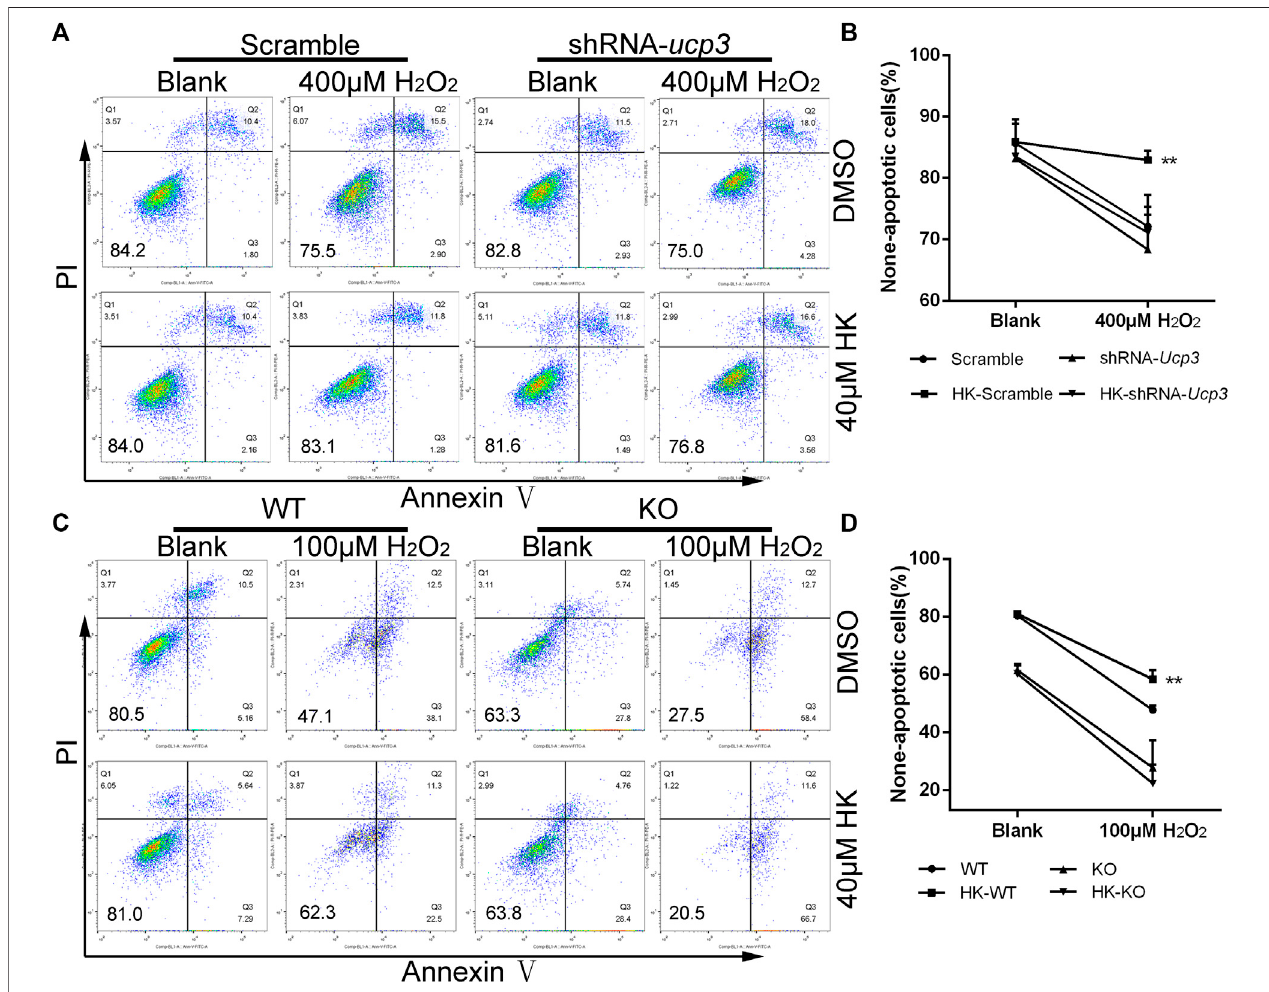
FIGURE 6 | Ucp3mediatestheprotectionofHKagainstoxidativedamageincardiomyocyteH9c2andneonatalmicecardiomyocyte.Forapoptosisdetection,Wild-typeH9c2 andH9c2cellswithdisturbedUcp3expressionorprimarycardiomyocytesfromWTandUcp3-KOmicewereculturedinsixwelldishfor12 hinthepresenceorabsenceof40 μ MHK, respectively. The H9c2 medium was then replaced with normal medium containing 400 mM hydrogen peroxide (A,B) and primary cardiomyocytes replaced with normal medium containing100 mMhydrogenperoxide (C,D) for12 htoinduceoxidativedamage.AnnexinV-FITC/PIApoptosisDetectionKitwasusedforapoptosisassaybyFACSanalysis, data show quanti fi cation of none-apoptotic cells ( n = 3 per group). Values are shown as means ± SD. * p < 0.05 , ** p < 0.01 vs. 100/400 μ M H 2 O 2 treatment WT/Scramble